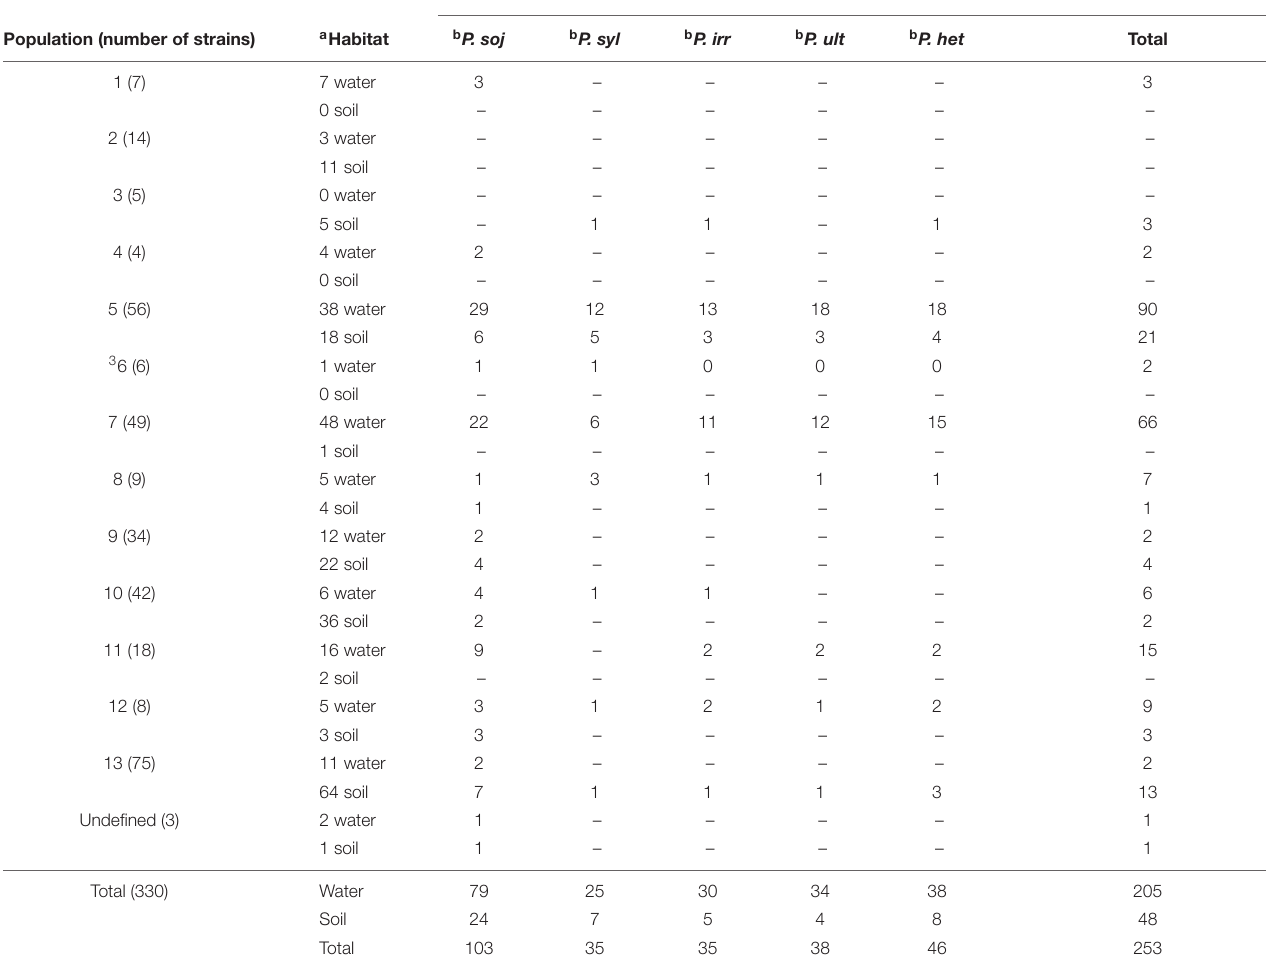
TABLE 1 | Numbers of antagonistic events against